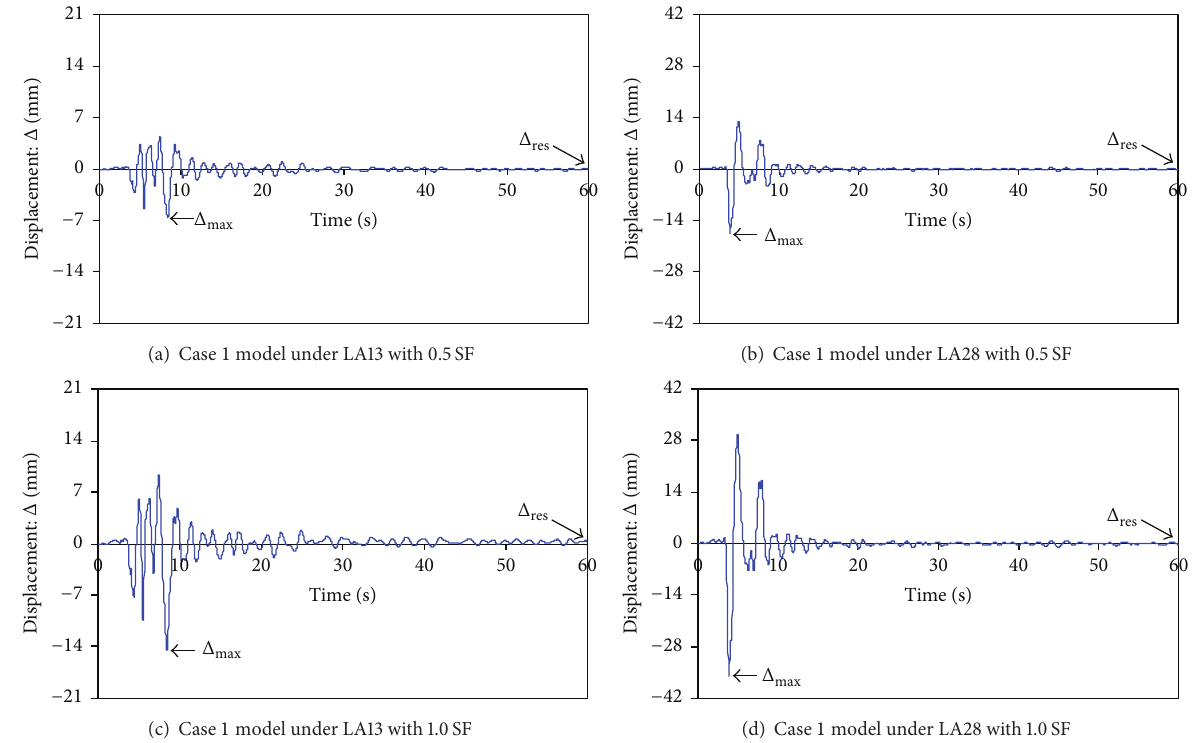
Figure 7: Displacement versus time curves for the SFDB model (Case 1 ) under representative ground motions with Scale Factors (SFs).